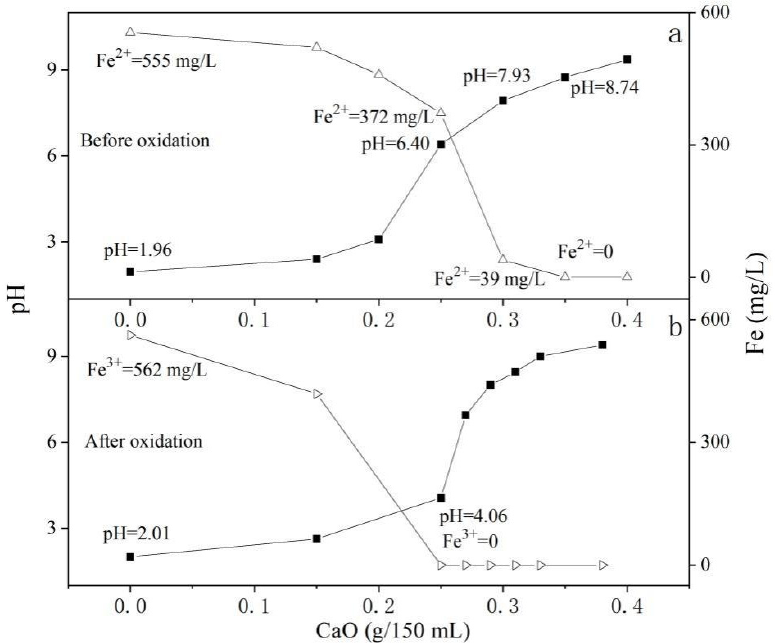
Figure 8. The effect of CaO amount on the pH and soluble Fe of the Fe 2+ -rich simulated acid mine drainage before ( a ) and after ( b ) oxidation.